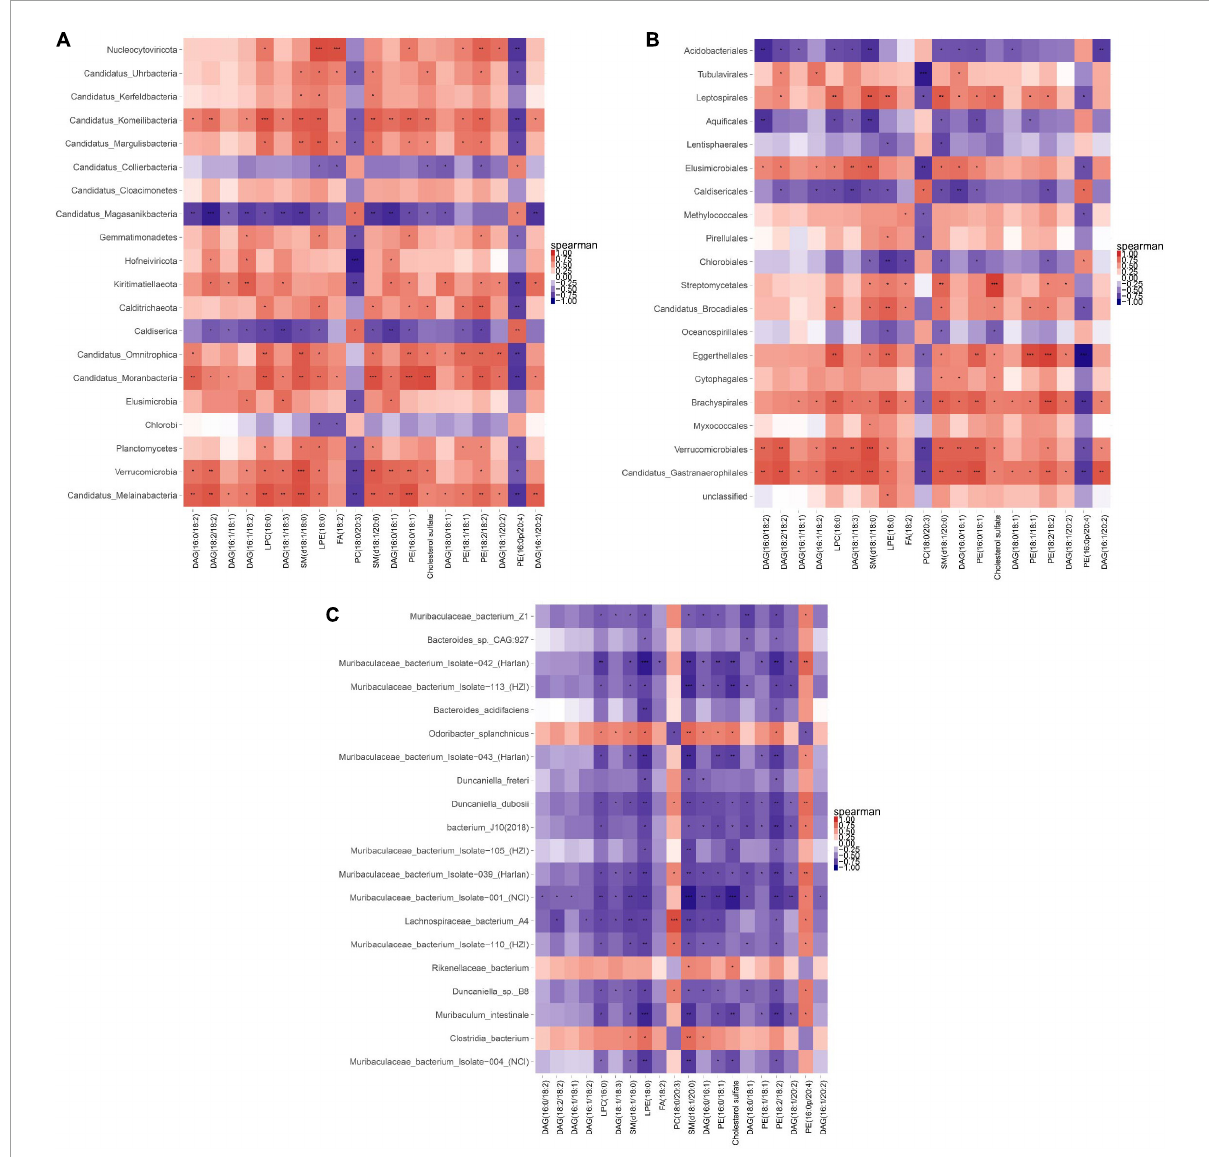
FIGURE12 Correlation heat map of metagenomic and lipidomics. (A) Correlation analysis at the Phylum level. (B) Correlation analysis at the Order level. (C) Correlation analysis at the species level. For each species/gene that behaves differently, each column is listed as the corresponding metabolite. The orange color showed a positive correlation, while the blue color showed a negative correlation. The deeper the color was, the greater the correlation would be. The closer the color was to white, the closer the correlation would be to zero. *** P < 0.001; ** P < 0.01; * P <